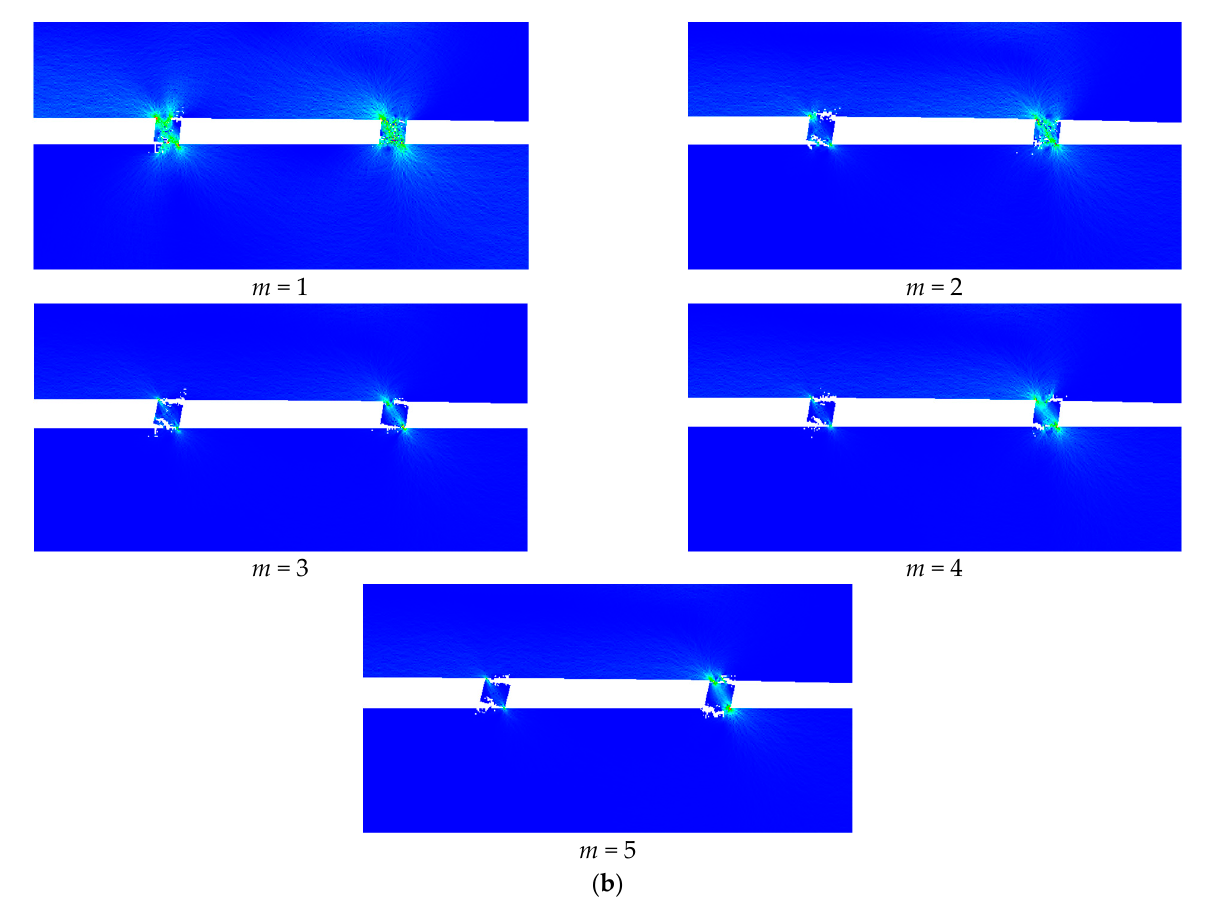
Figure 8. Failure patterns of models ( a ) with different depth of right locked patches; ( b ) with different homogeneity of right locked patches.